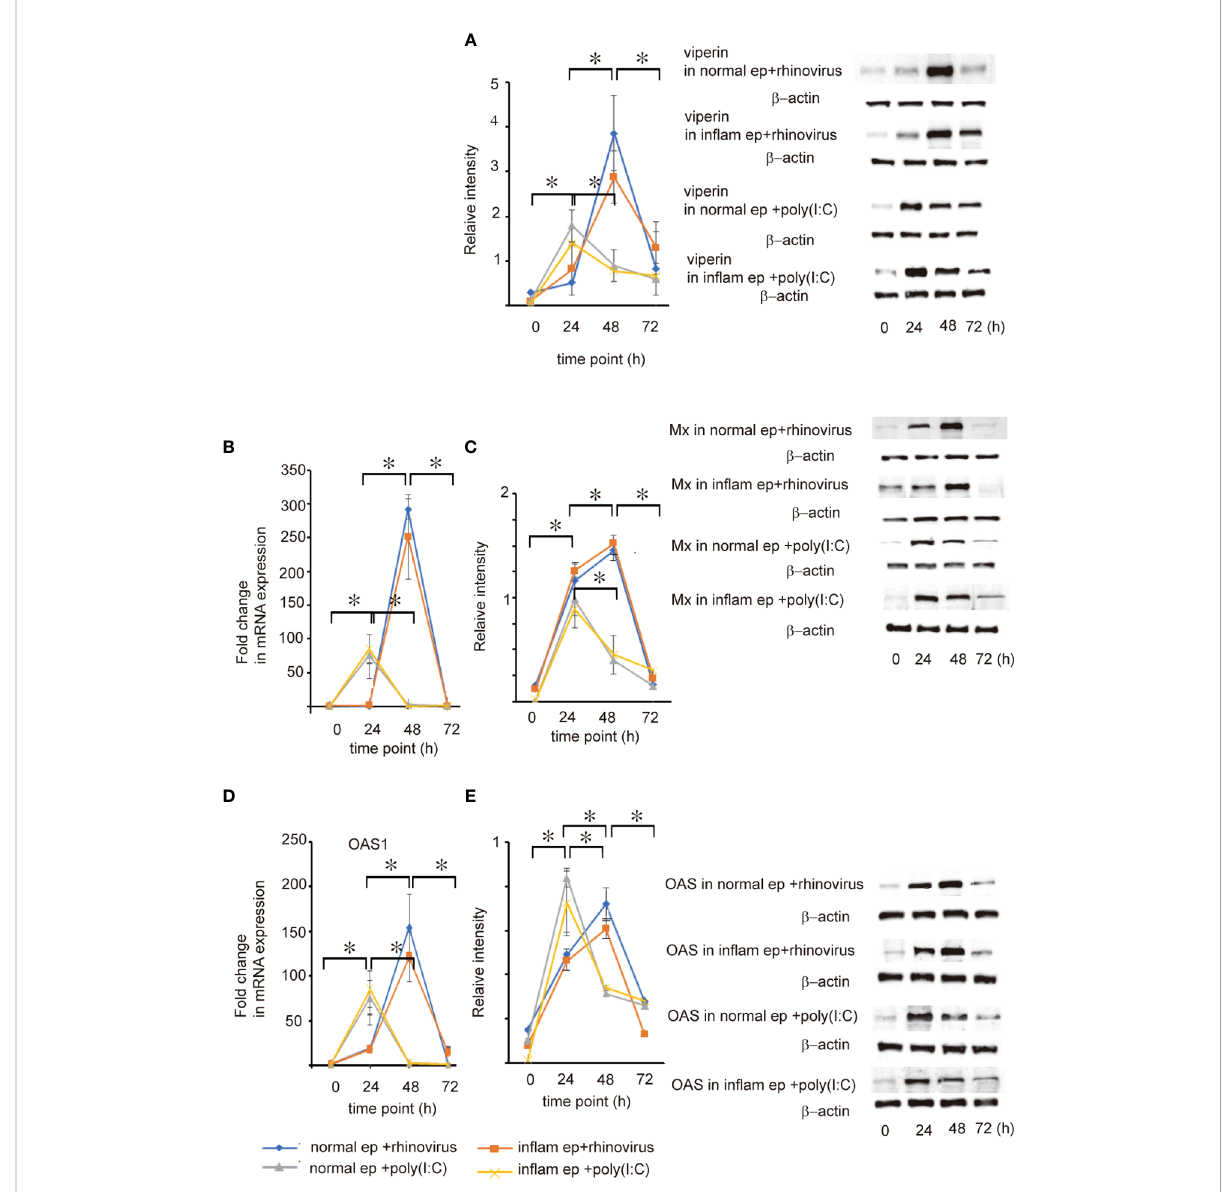
FIGURE 3 The expression level of viperin, Mx, and OAS mRNA and protein expression in cultured normal and in fl ammatory sinonasal epithelial cells obtained from healthy control and patients with CRSwNP, respectively. Their levels were evaluated 24, 48, and 72 h after RV 16 inoculation and poly (I: C) treatment, which were evaluated by RT – qPCR (B, D) and western blot (A, C, E) . Right panels located in the fi gure show representative protein bands evaluated with western blot. Data are mean ± SEM from 7 different epithelial donors. Normal ep + rhinovirus indicates that cultured epithelial cells were infected with RV. In fl am ep + rhinovirus indicates that cultured in fl ammatory epithelial cells were infected with RV. Normal ep + poly (I: C) means poly (I: C)-treated cultured normal epithelial cells. In fl am + poly (I:C) means poly (I:C)-treated cultured in fl ammatory epithelial cells. * indicates a signi fi cant difference between each